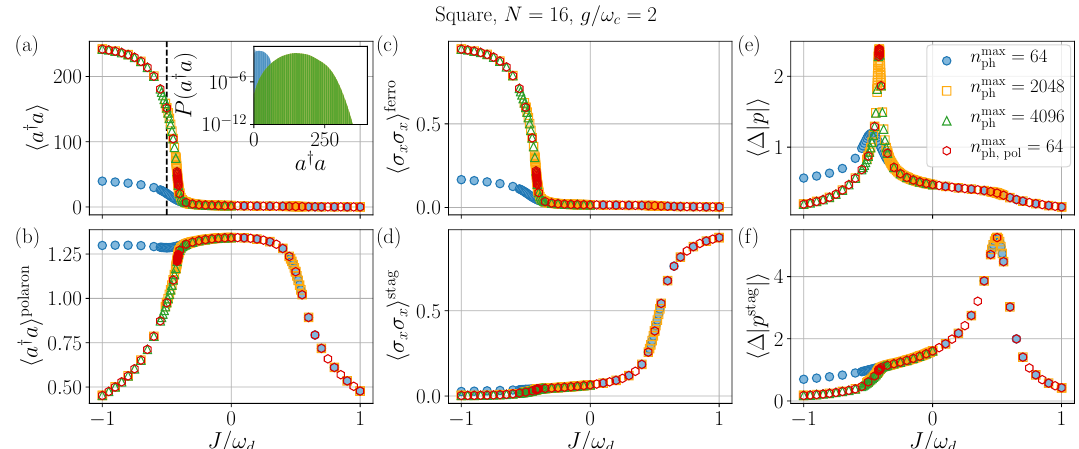
Figure 7: Scaling of observables with the photon number cutoff. Different symbols in- dicate different photon number cutoffs n max used in the simulations. The red hexagon ph shows results of a simulation in the polaron frame, while all other symbols represent simulations in the standard frame. (a) Photon number and (b) polaron photon num- ber, (c-d) order parameter correlations for the (c) ferroelectric, and (d) Néel phase, (e-f) fluctuations of the (e) polarization, (f) staggered polarization. The inset in (a) = − 0.5, as shows the ground state distribution of the photon number a † a for J /ω d = 64 ( 4096 ) in blue (green) indicated by the vertical dashed line, for n max ph